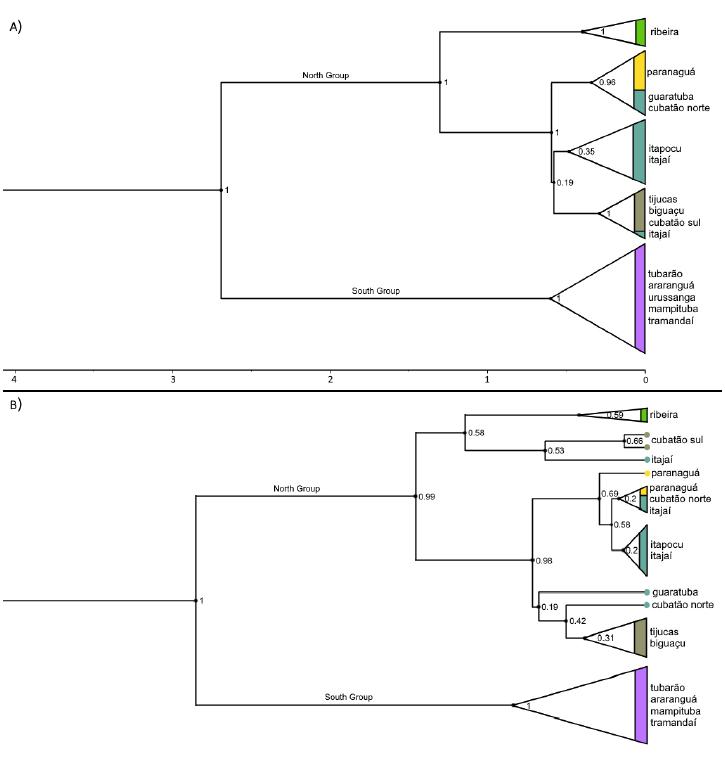
FIGURE 2 | Phylogeny of Hisonotus leucofrenatus samples. A. Cytochrome Oxidase subunit 1; and B. rpS7 ribosomal protein gene intron 1 sequences. Numbers represent posterior probabilities of the respective node. Terminals collapsed into large and well supported group and colors represent paleodrainages according to Fig. 1. In (A) X axis represents time